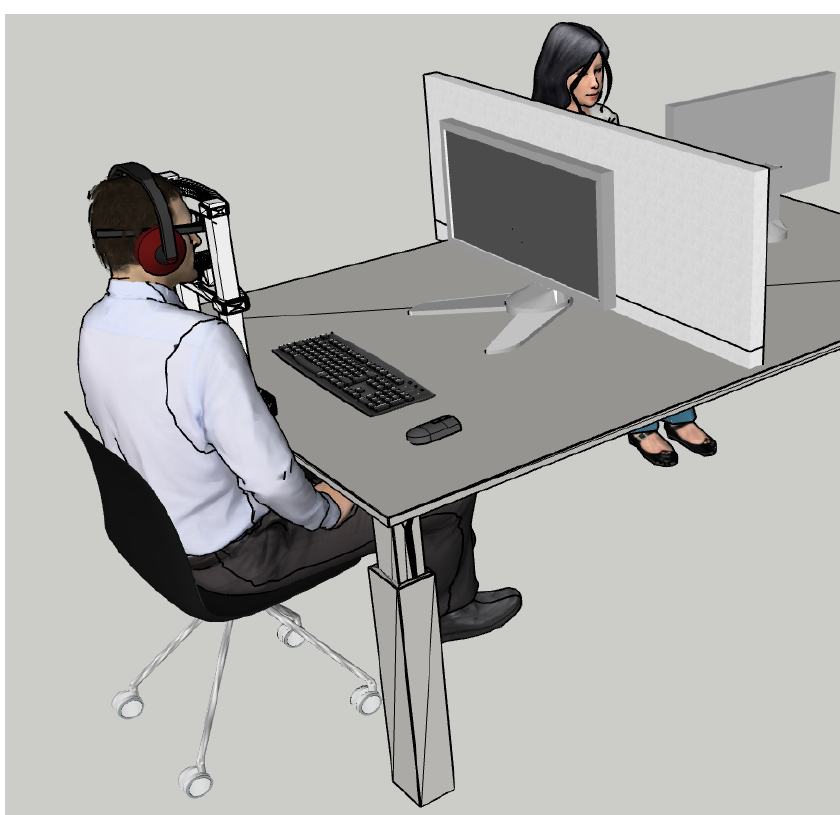
Figure 2. Graphical illustration of the experimental